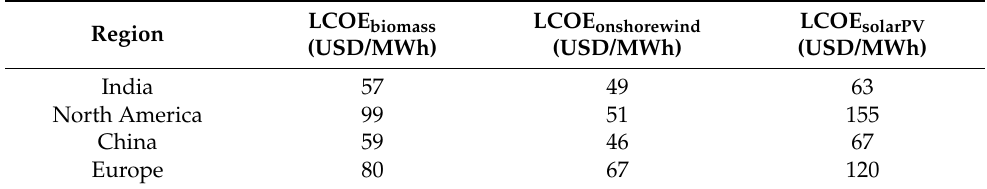
Table 9. Weighted-average LCOE of biomass-fired electricity generation and comparison with other renewable technologies (2019). Data adapted from [49], ISBN 978-92-9260-244-4. LCOE biomass Region